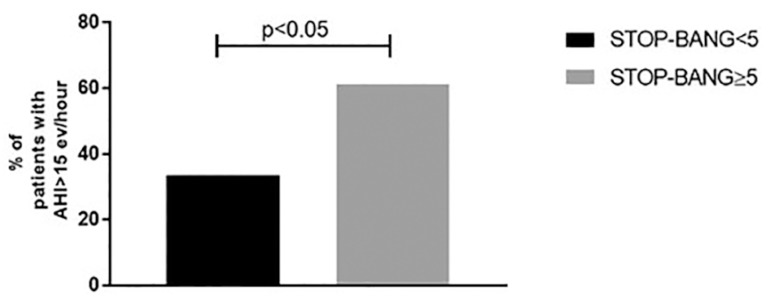
Relationship between > 5 or < 5 SBQ components and AHI.